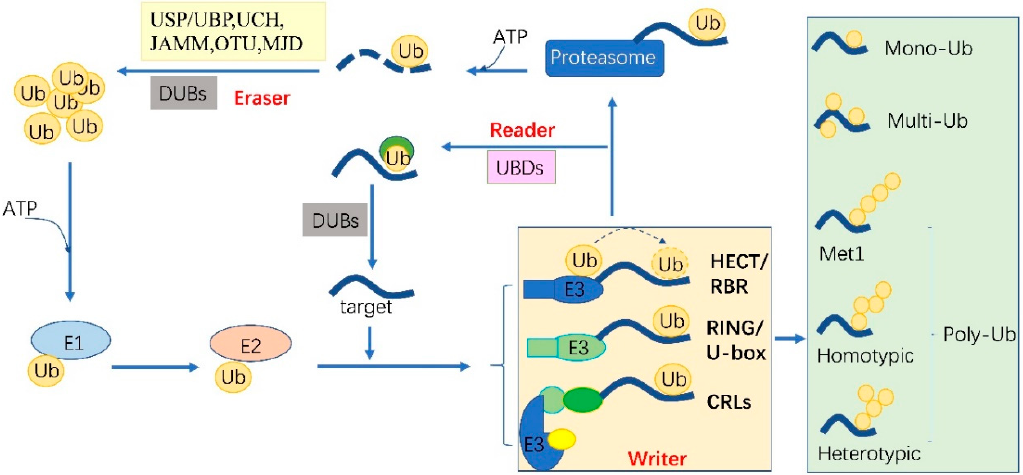
Figure 1. The protein ubiquitylation cascade and its components. Free Ub (Ub) molecules are activated through 3 sequential reactions catalyzed by a Ub-activating enzyme (E1), Ub-conjugating enzyme (E2) and Ub ligase (E3) in an ATP-dependent manner. Based on the transferring mode of Ub Figure 2, the E3s (writer of ubiquitylation) are classed into HECT, RBR, RING, U-box and Cullin-RING E3 ligases. Ub linkage can form into mono-, multimono- (multi-) or poly- ubiquitylation. Ubiquitylation sites are recognized by the proteins carrying Ub binding domains (UBDs, reader of ubiquitylation, including the cap of proteasome) and then direct the targets to be recycled by the deubiquitylases (DUBs, eraser, USP / UBP, UCH, JAMM, OTU and MJD in plants) or 26S proteasome-mediated degradation. HECT, homologous to E6-associated protein C-terminus; RBR, RING-in-between-RING; U-box, a modified RING motif without the full complement of Zn 2 + -binding ligands; USP / UBP, ubiquitin-specific proteases / ubiquitin-specific processing enzymes; UCH, ubiquitin carboxyl-terminal hydrolases; OUT, ovarian tumor proteases; JAMM, JAB1 / MPN / MOV34 domain associated metalloisopeptidase; MJD, Machado-Joseph family